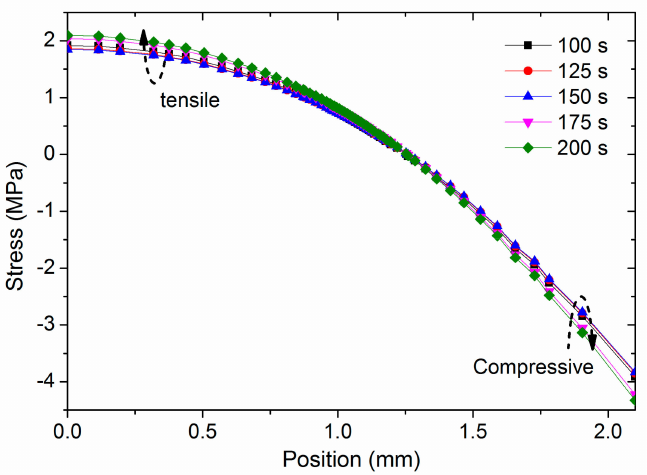
Figure 13. Stress evolution in stage 3.